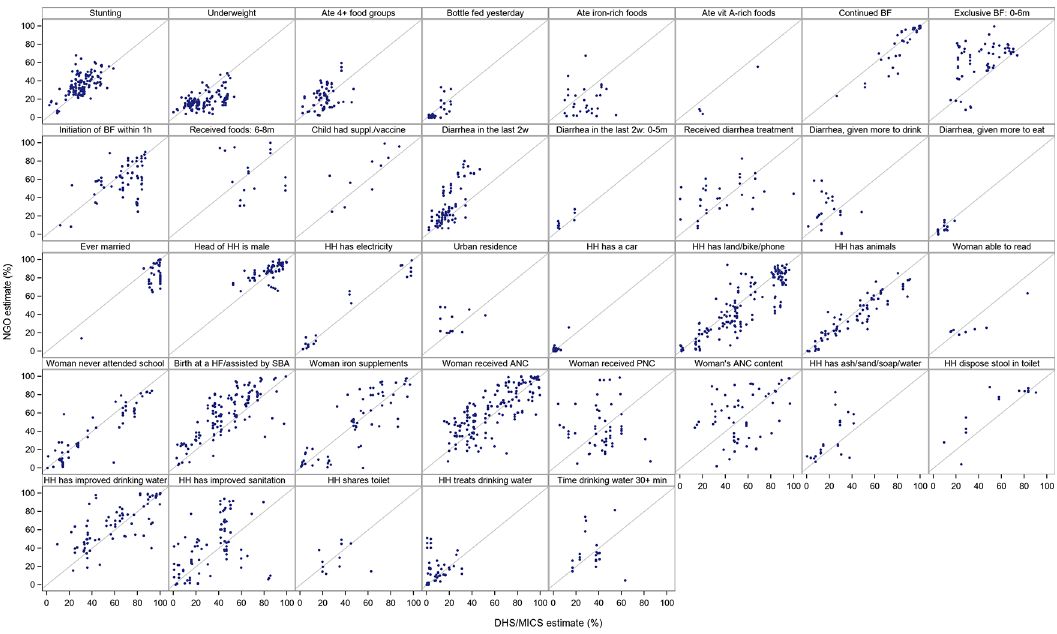
Figure 1. DHS/MICS estimate by NGO estimate by subgroup of indicators. Abbreviations: BF: breastfeeding; HH: household; HF: health facility; SBA: skilled birth attendant; ANC: antenatal care; PNC: postnatal care; DHS: Demo- graphic and Health Surveys; MICS: Multiple Indicator Cluster Surveys; NGO: non-governmental